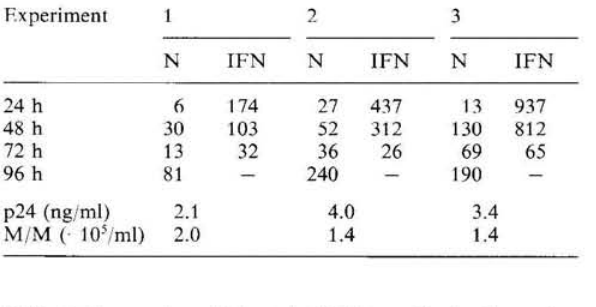
Table 2. Neopterin and biopterin (Ν, B; pmol/ml) release after cocultivation of uninfected or HIV-infected M/M with